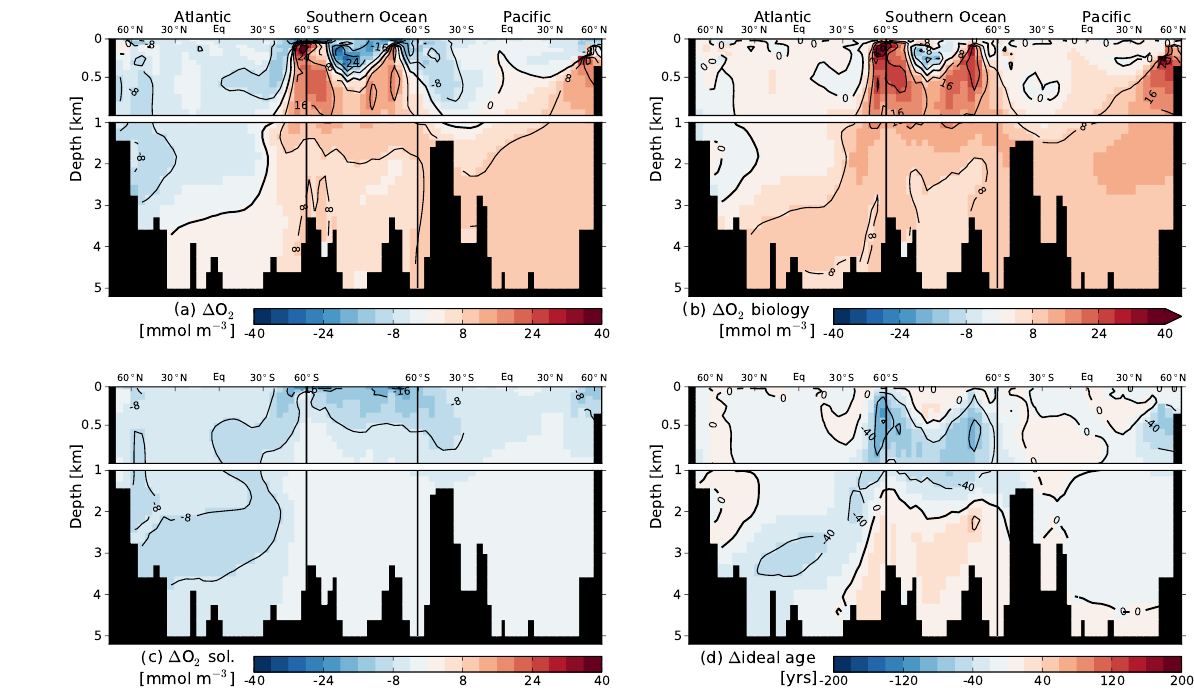
Figure A3. Changes in O 2 and its components for new steady-state conditions relative to preindustrial steady state for a single representative ensemble member reaching the 1.5 ◦ C warming target. (a) Change in total O 2 , (b) change in O 2 due to biology, (c) change in O 2 due to solubility, (d) changes in ideal